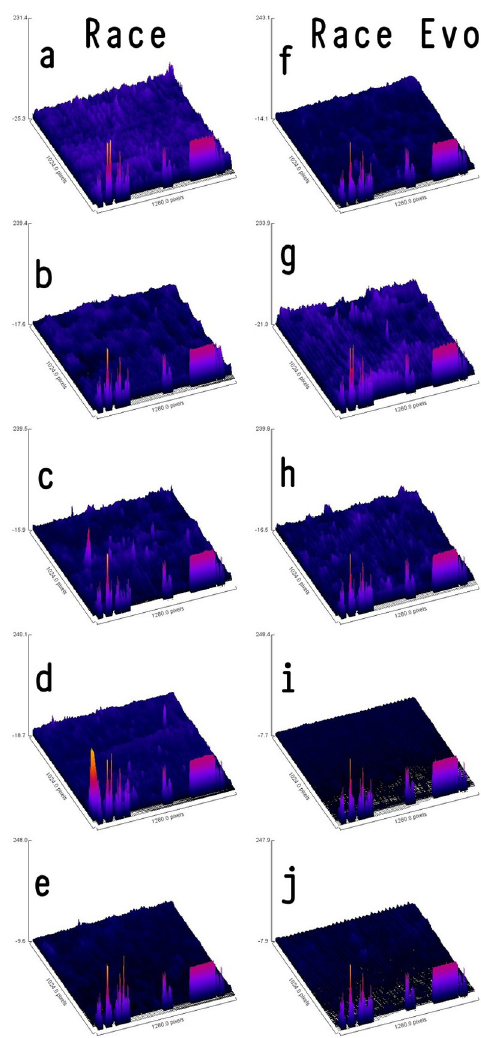
Fig 1. 3D color surface roughness profiles of Race and Race Evo files (magnification 450x) where x = 1280 px; y = 1024 px and z (intensity) - 26 to 249 representing the lowest valley and highest peak. a) 0 cycle Race, b) one-time cycled Race, c) three times cycled Race, d) five times cycled Race, e) ten times cycled Race, f) 0 cycle Race Evo, g) one- time cycled Race Evo, h) three times cycled Race Evo, i) five times cycled Race Evo, and j) ten times cycled Race Evo.